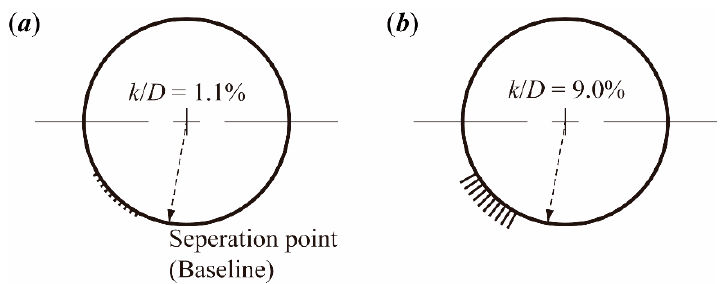
Figure 5. A schematic of overall profile of a circular cylinder with microfiber coating at a coating location of θ = 30°: ( a ) k / D = 1.1%; ( b ) k / D = 9.0%.